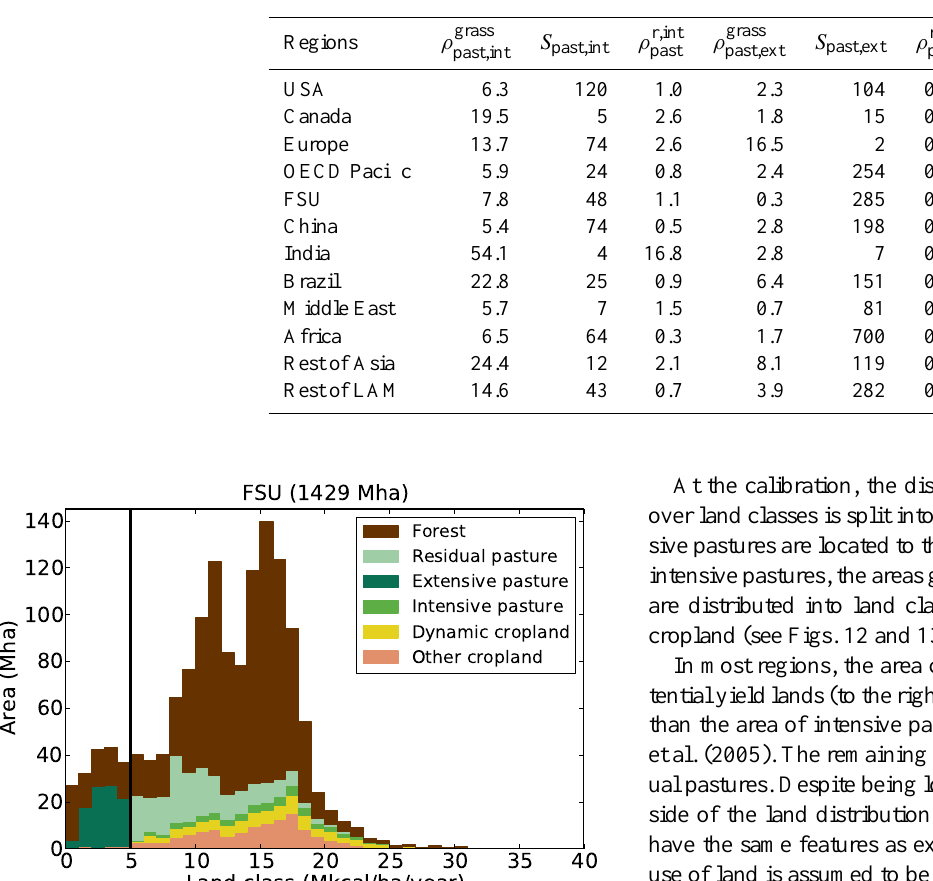
/(β r,int φ grass ) ) in past,int r,int